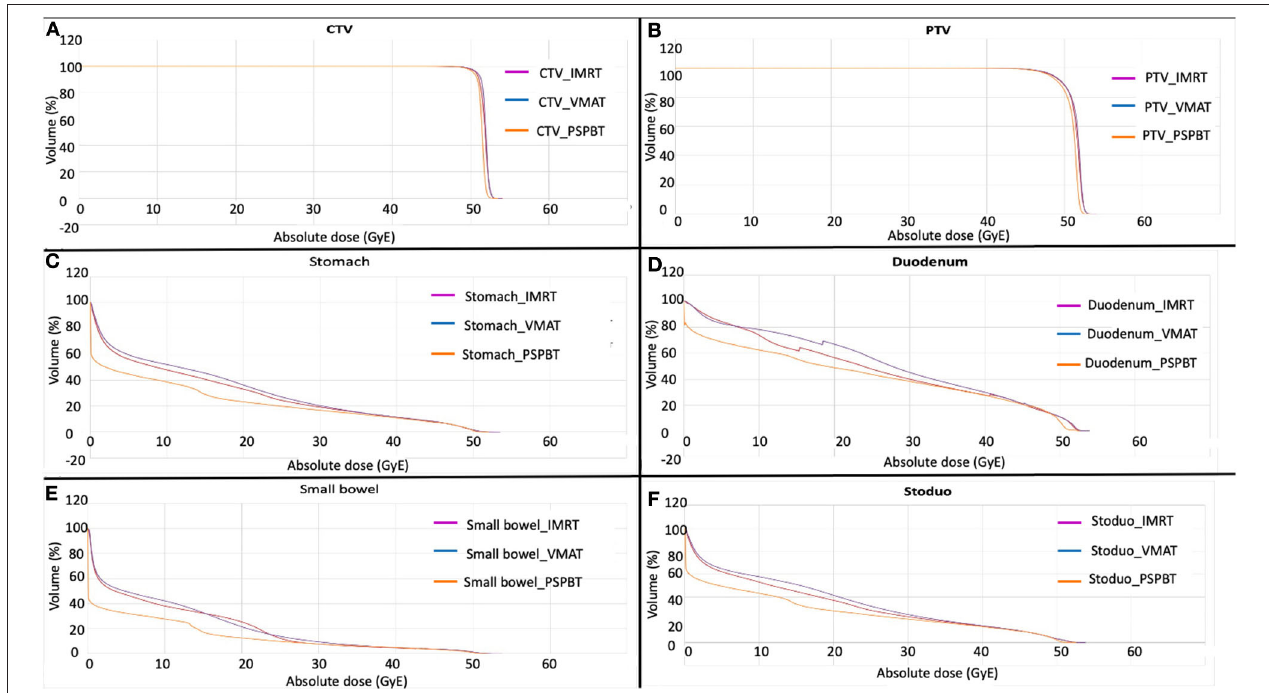
FIGURE 3 | Average cumulative dose–volume histogram (DVH) of each plan in each cohort for tumor volumes [CTV (A) and PTV (B) ] and gastrointestinal organs at risk (GI-OARs) [stomach (C) , duodenum (D) , small bowel (E) , and stoduo (F) ]. Yellow , 3D-passive scattering proton beam therapy (3D-PSPBT); magenta , intensity-modulated radiotherapy (IMRT); purple , volume-modulated arc therapy (VMAT).